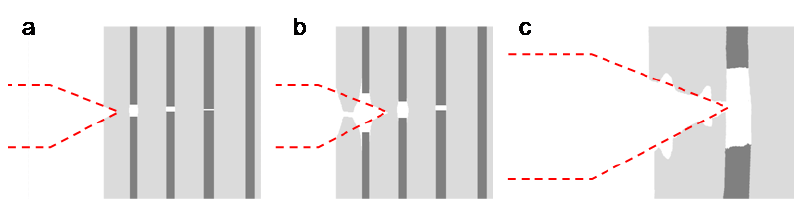
Figura 11: Schema di propagazione di una cricca di fatica in una colonia perlitica (a,b); formazione di striature alla sommità di una lamella di ferrite rotta (c). Figure 11: Propagation scheme of a fatigue crack through a pearlite colony (a,b); striations formation at the top of a broken ferrite lamella